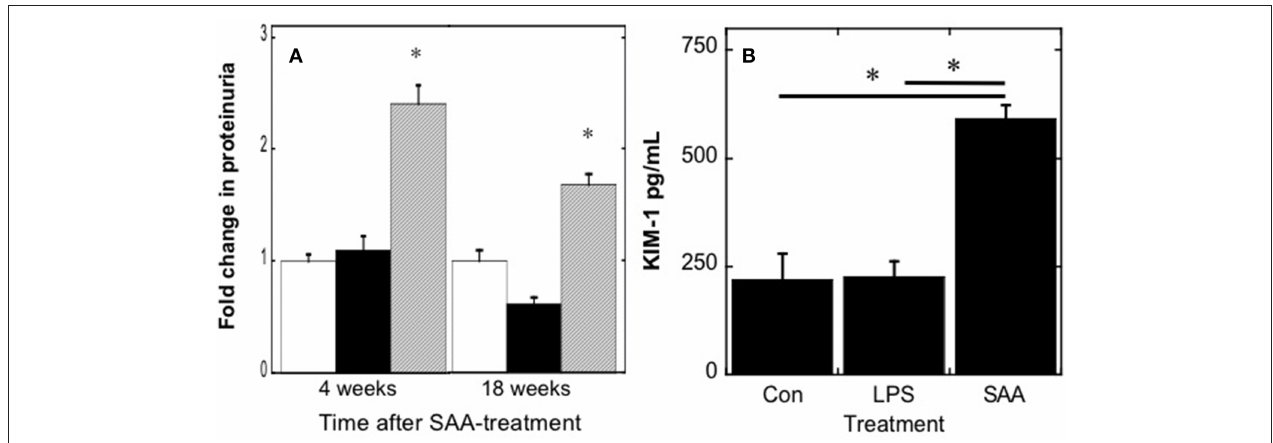
FIGURE 4 | Urinary protein and kidney injury molecule-1 increase in mice after SAA administration. ApoE − / − mice were treated with SAA, LPS or sterile PBS by i.p. injection over 2 weeks (as described in Study 1). Total protein (A) was quantified in urine samples from mice 4 or 18 weeks after commencement of SAA-treatment; open, black and gray bars represent control, LPS and SAA-treated groups. To assess acute renal damage, (B) urinary KIM-1 concentrations were determined in samples obtained 4 weeks after commencement of SAA-treatment using a commercial ELISA kit. Data represent mean ± SD ; n = 8 (control and LPS) or 10 (SAA) mice. *Different to control and LPS-treated mice in the absence of SAA; P < 0.05.